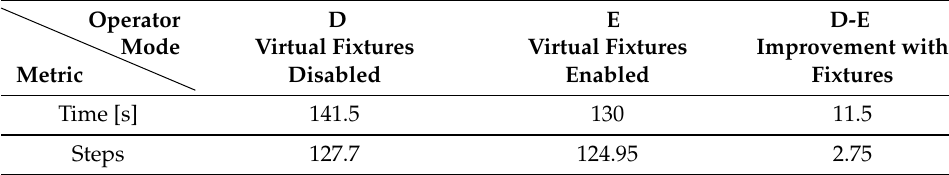
Table 3. Experiment II Mean Time to Completion and Mean